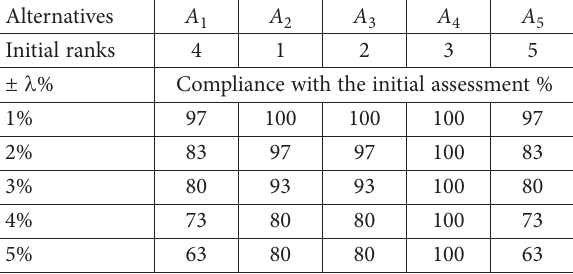
Table 5. Sensitivity assessment according